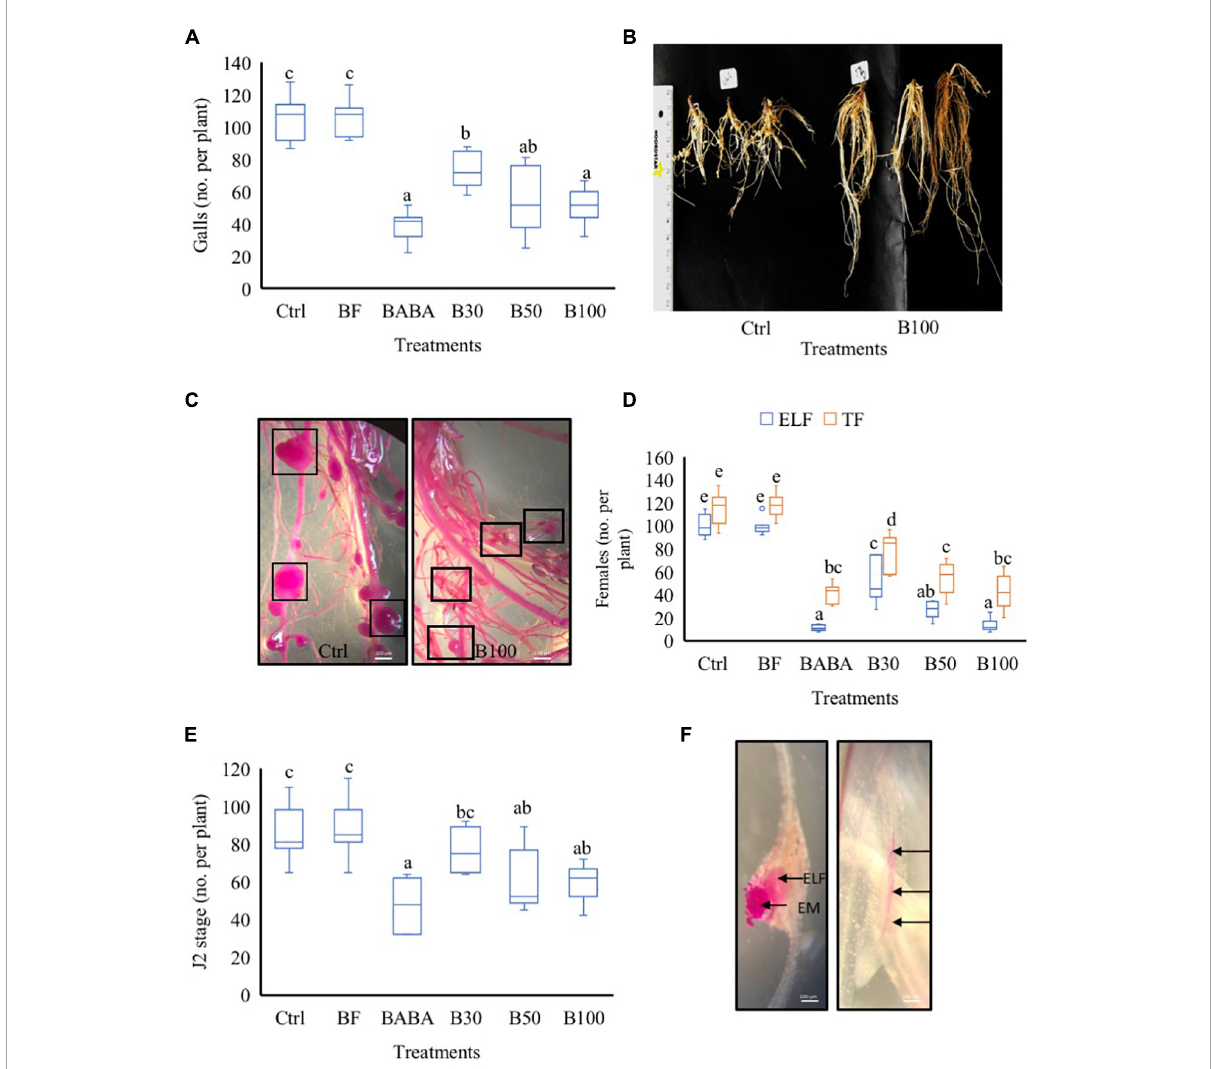
FIGURE2 Effect of P. polymyxa LMG27872 strain on M. incognita parasitism in tomato. (A) Total number of galls at 42 dpi. (B) Nematode-parasitized roots of the control group and B100-treated plants at 42 dpi. (C) Acid fuchsin-stained roots showing gall sizes in the control group vs. B100-treated plants at 42 dpi. (D) Number of total females (TF) and the number of egg-laying females (ELF) at 42 dpi. (E) Total number J2 at 2 dpi and (F) acid fuchsin-stained roots of ELF embedded inside the gall, egg mass (EM) on the surface, and J2 inside the roots (depicted with black arrows). Data were analyzed by one-way ANOVA, followed by Tukey’s post-hoc test, and data are shown by box plots with median, upper quartile, and lower quartile. Different letters indicate statistically different means at 95% confidence. Each treatment was replicated eight times ( n = 8), and each experiment was repeated at least two times. Bars = 100 µ